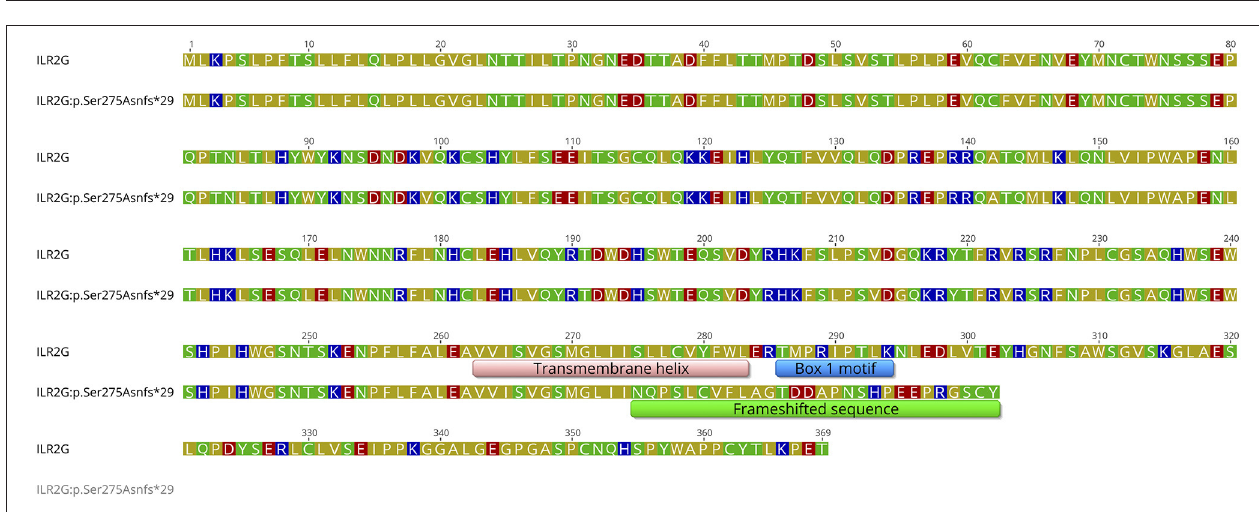
FIGURE 4 | A sequence alignment of the wild-type ILR2G and the variant ILR2G: p.Ser275Asnfs*29 proteins. The transmembrane region and the “Box 1 motif” regions of the wild-type protein are annotated along with the frameshifted sequence of the variant ILR2G. Amino acids are colored based on their polarity: blue - basic; red - acidic; green - polar; olive -